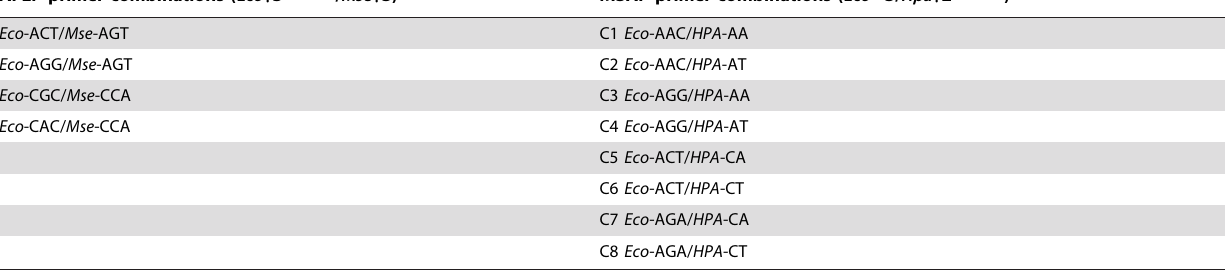
AFLP primer combinations ( Eco + 3 labeled / Mse + 3)